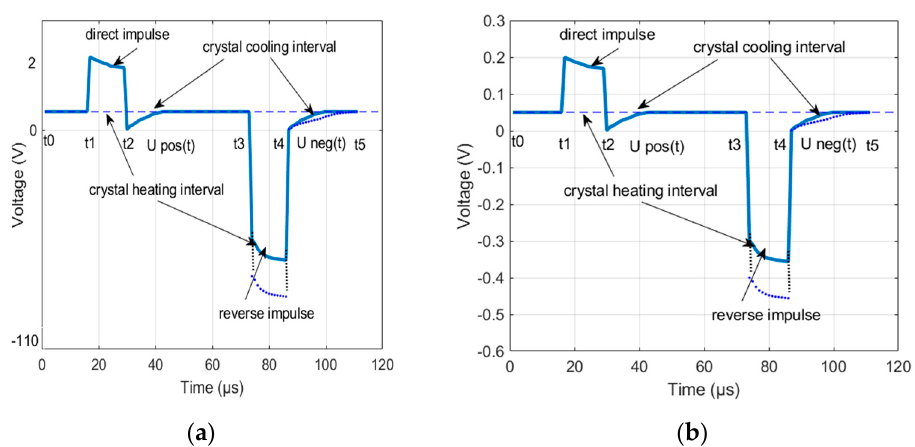
Figure 1. Diagram of voltage variation across an LED, having three heating and cooling periods of the crystal during the LED test. ( a ) The positive signal and the negative signal are presented in the different scales. ( b ) The different gains for positive and negative signals are provided in measuring channels. The gain 1/10 was established for the positive signal and 1/100 for the negative signal.